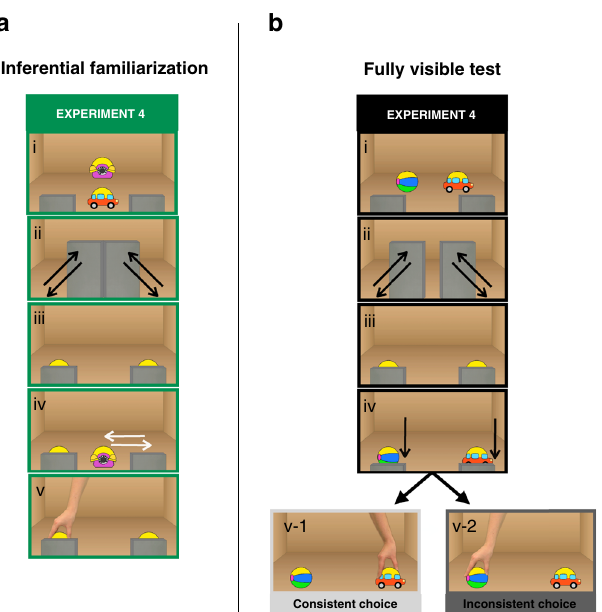
Fig. 3 Experiment 4. Structure of the familiarization and test movies. a Infants were familiarized with hiding events that prevented tracking the identity of the objects (i – iii), followed by actions toward a partially covered object (v), whose identity had to be inferred via disjunctive inference (iv). b Infants ’ knowledge of the agent ’ s goal was tested with hiding/revealing events (i – iv) followed by a consistent (v-1) or an inconsistent choice (v-2) targeting two fully visible objects (the goal-object and a new